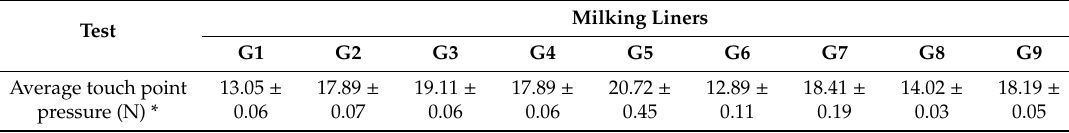
* Average among four repetitions.